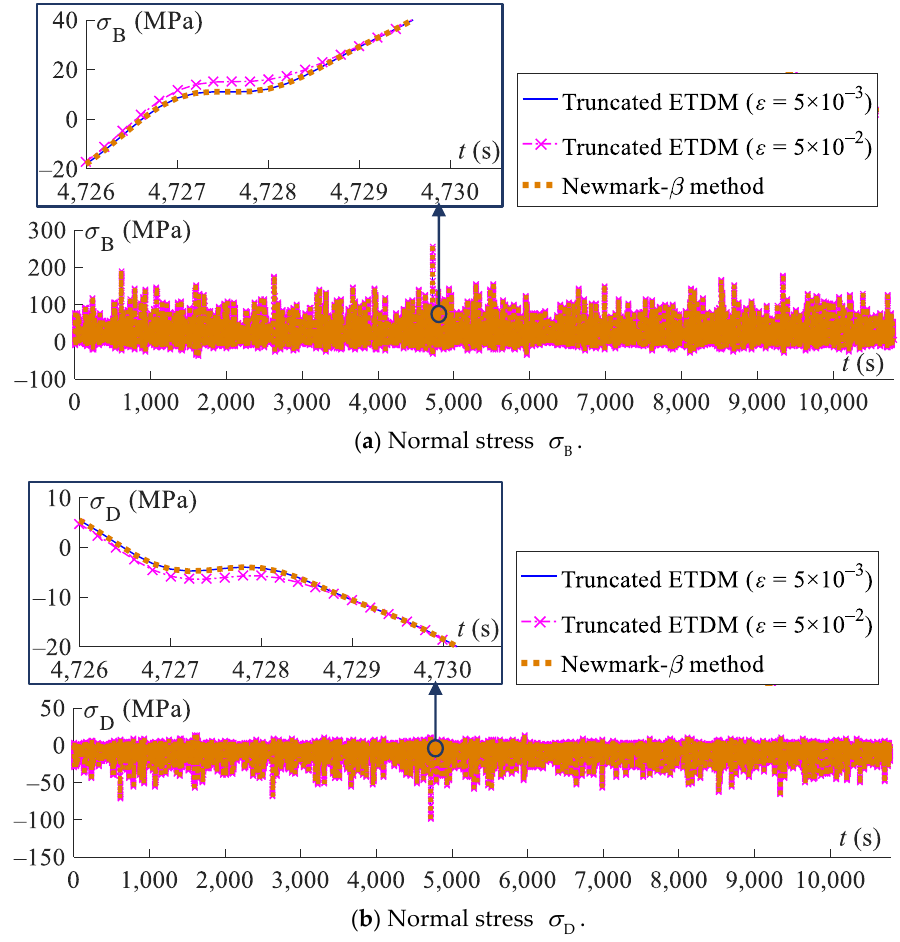
Figure 7. Normal stresses at sections B and D of the battered legs of the jacket platform.